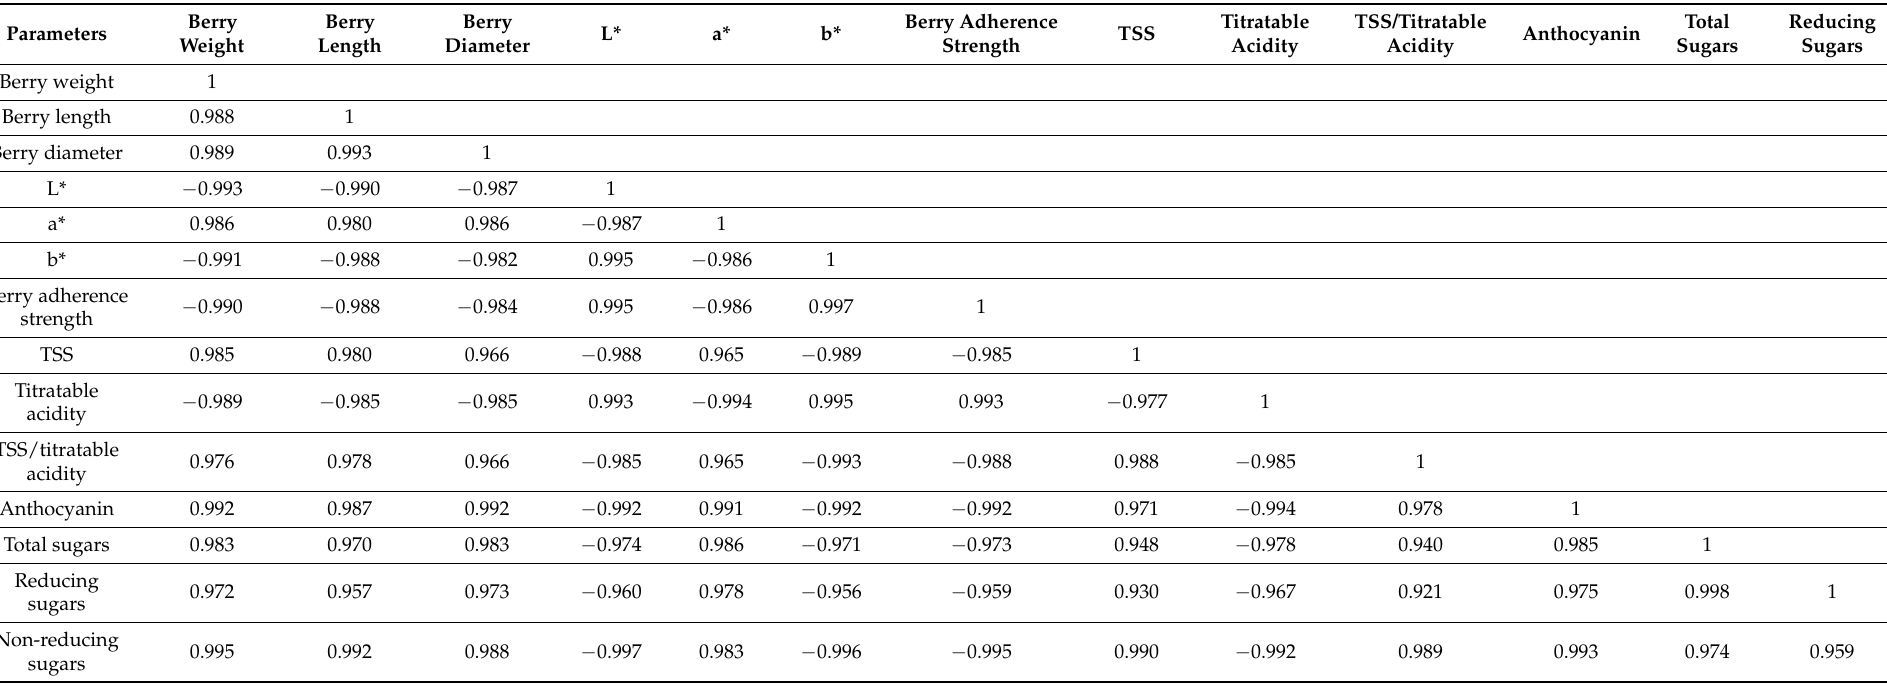
Table 4. Pearson’s correlation coefficients (r) describing the correlations among quality variables of Flame Seedless grape cultivated under various agronomical management and other